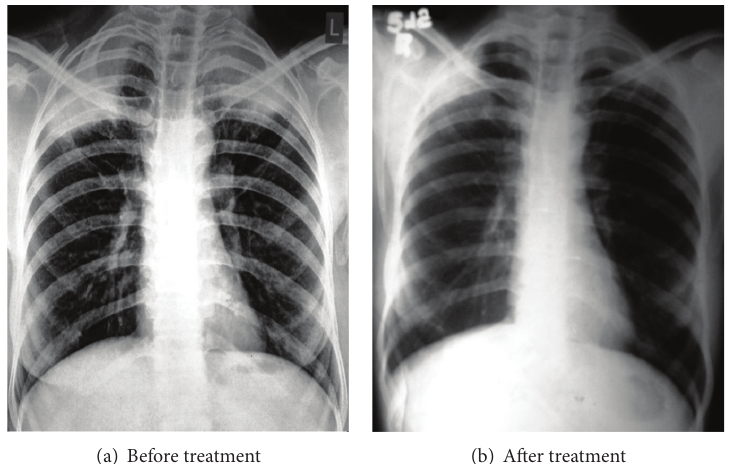
Figure 4: CXR-P.A. views showing pretreatment bilateral apical consolidations with necrosis (a) and posttreatment almost complete resolution of the lesions